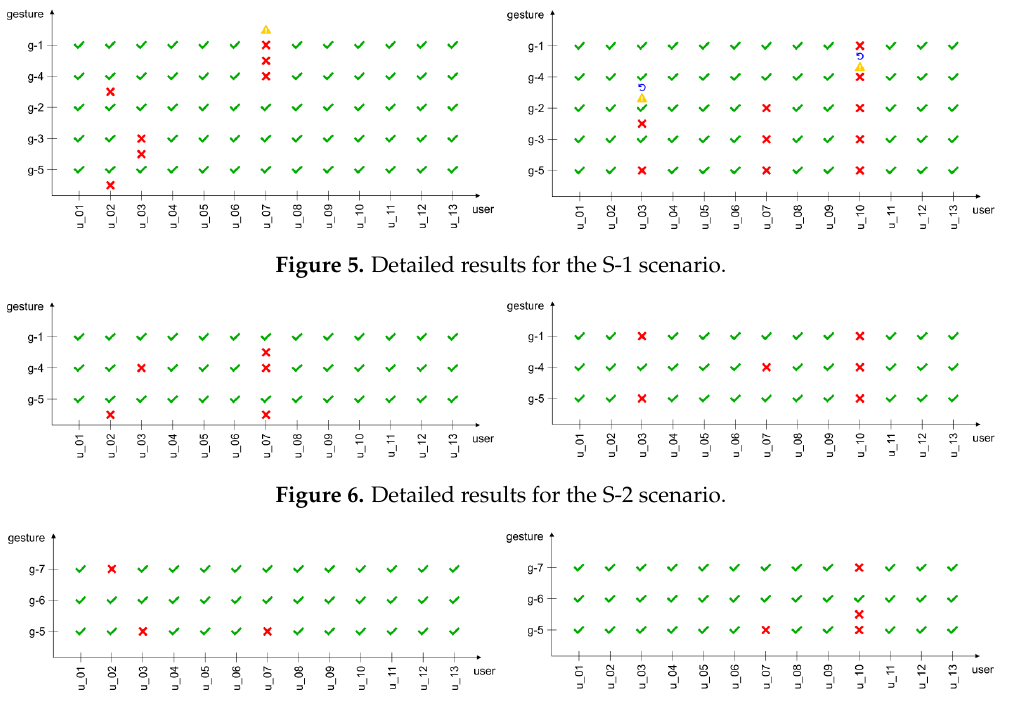
Figure 7. Detailed results for the S-3